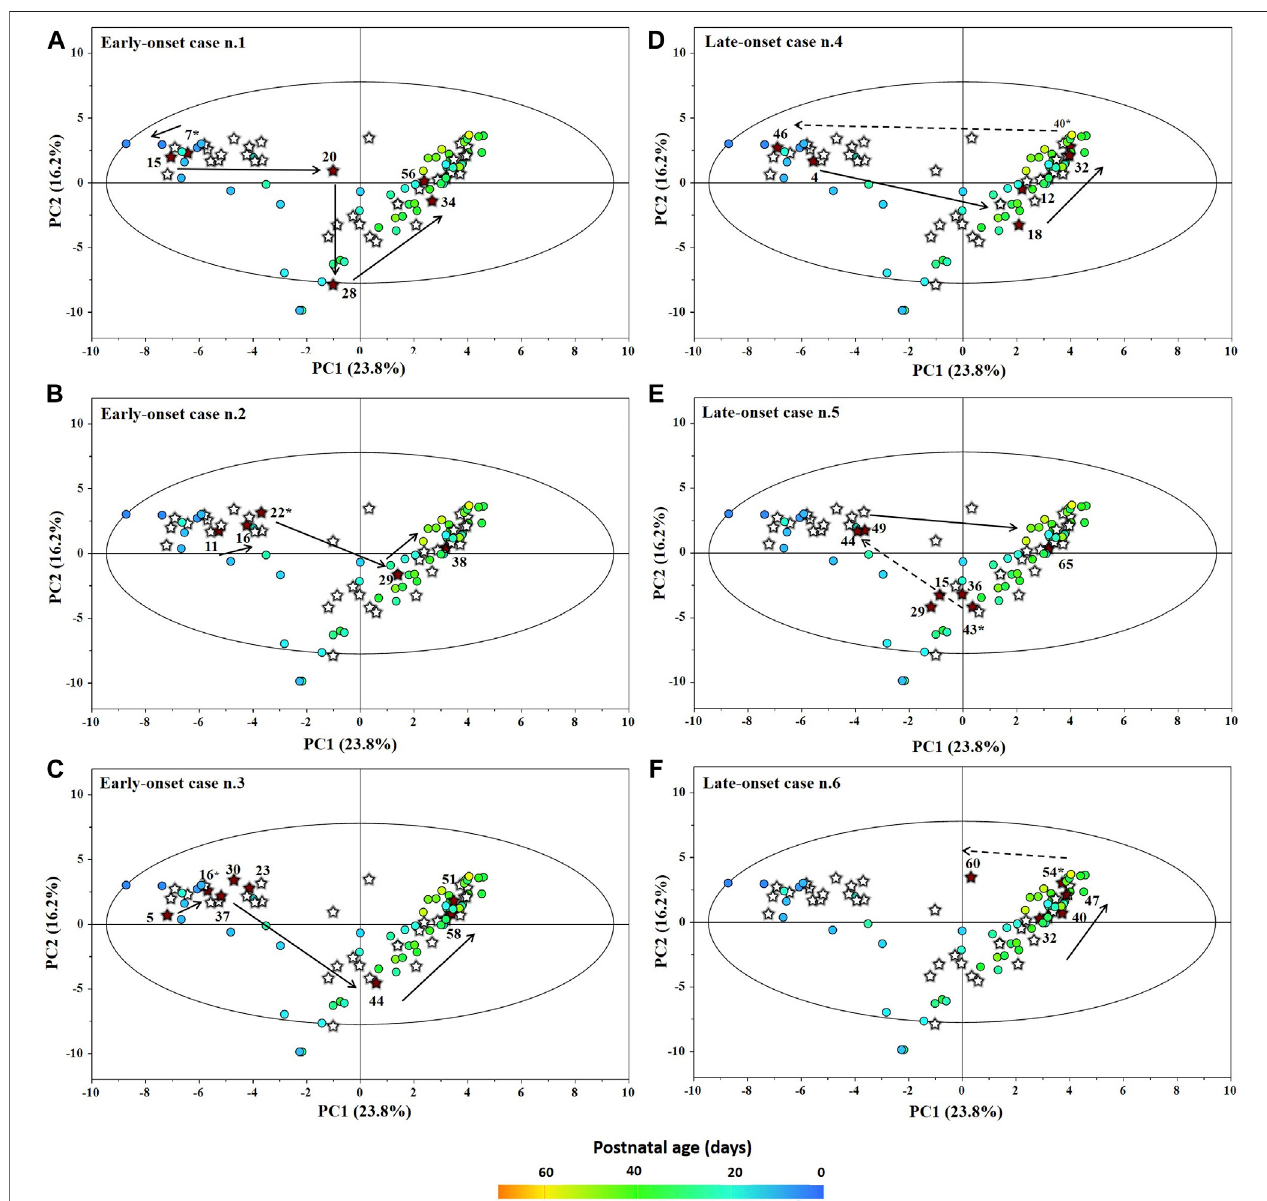
FIGURE 2 | Temporal trajectories (obtained from the model built with the 1 H-NMR spectra) of each individual early-onset (A – C) and late-onset (D – F) NEC baby in the PC1 vs PC2 scores plot. FI and GDT (o); NEC ( + ). Scores are colored according to the postnatal age. Numbers denotes the post-natal age of NEC at the time of sampling and the asterisk marks the day of the disease